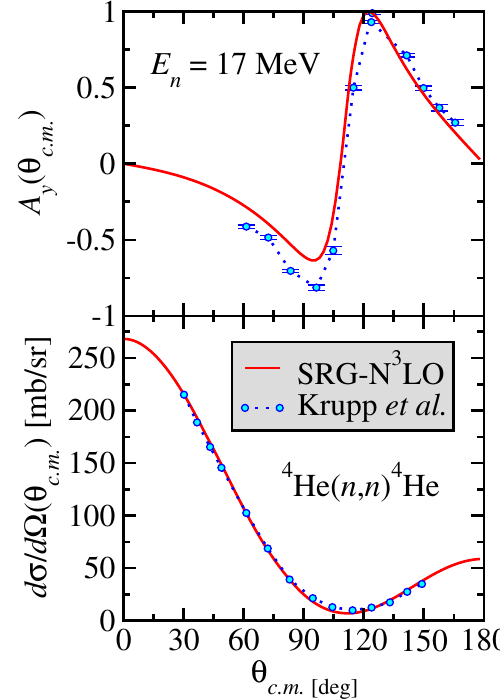
di ff erential cross section (bottom panel) for E n = 17 MeV (neu- tron laboratory energy) obtained in the model space N max = 17, including g.s. and 0 + 0 states of 4 He, for the SRG-N 3 LO [44] NN potential at (cid:2) Ω = 20 MeV, compared to the experimental data of Ref. [45].